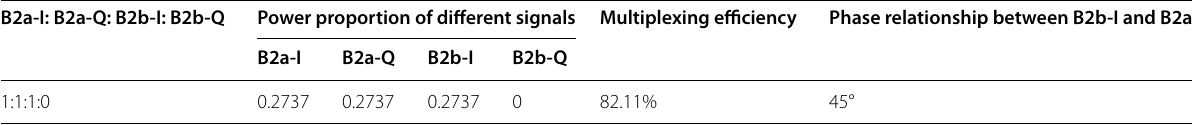
Table 4 Actual power and multiplexing efficiency of each component of Type-III ACE-BOC when the phase relationship between I-components is 45° B2a‑I: B2a‑Q: B2b‑I: